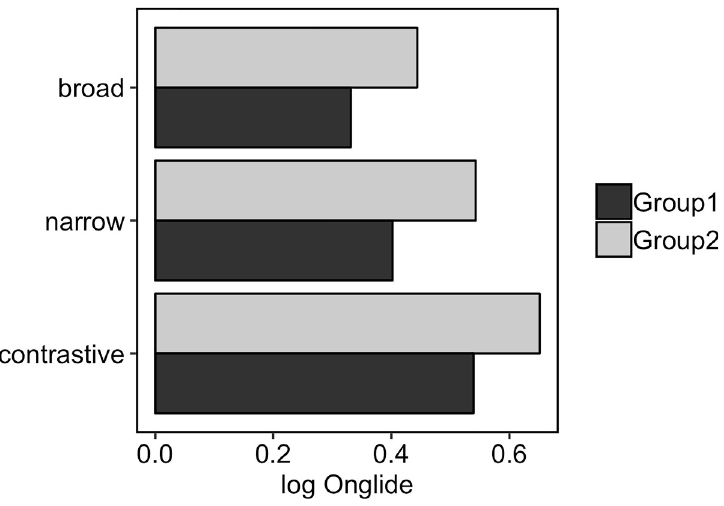
Fig 18. Medians of rising onglide distributions for the two speaker